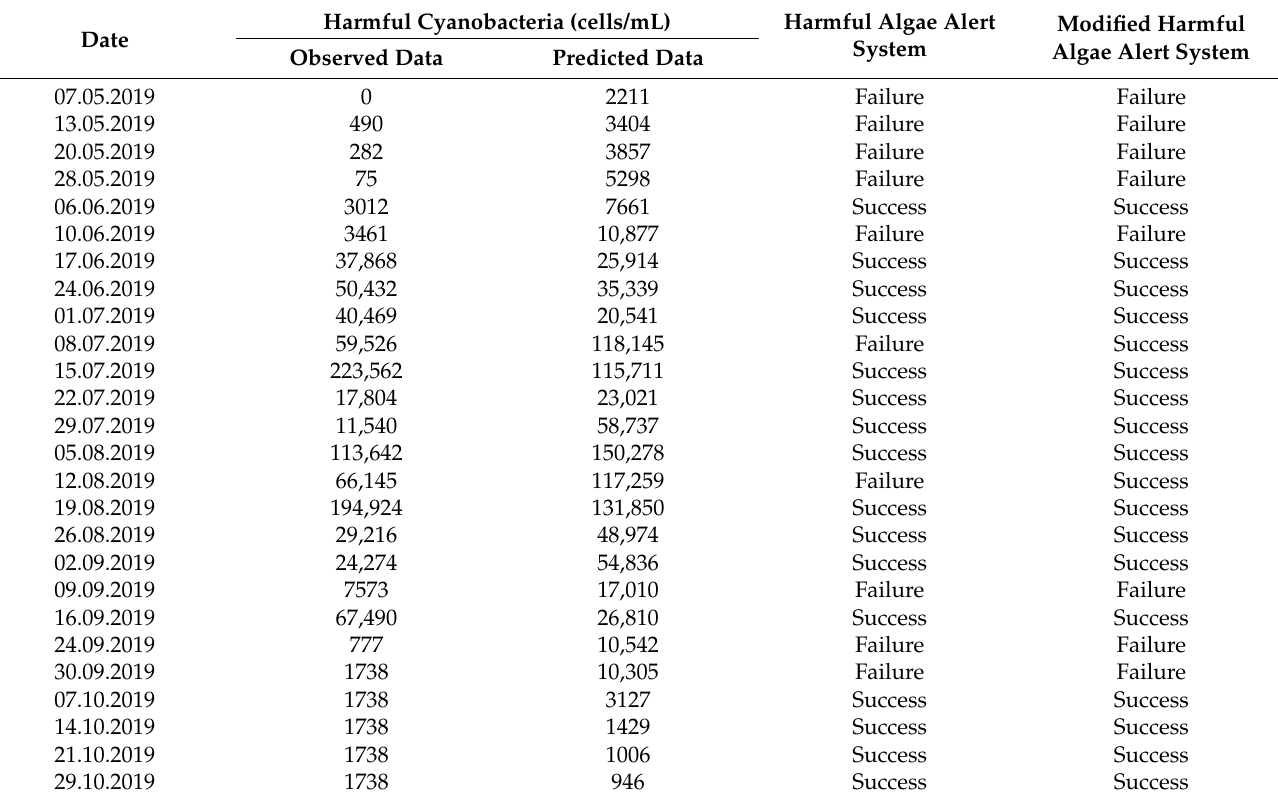
Table 7. The evaluation result of predicted success rate.